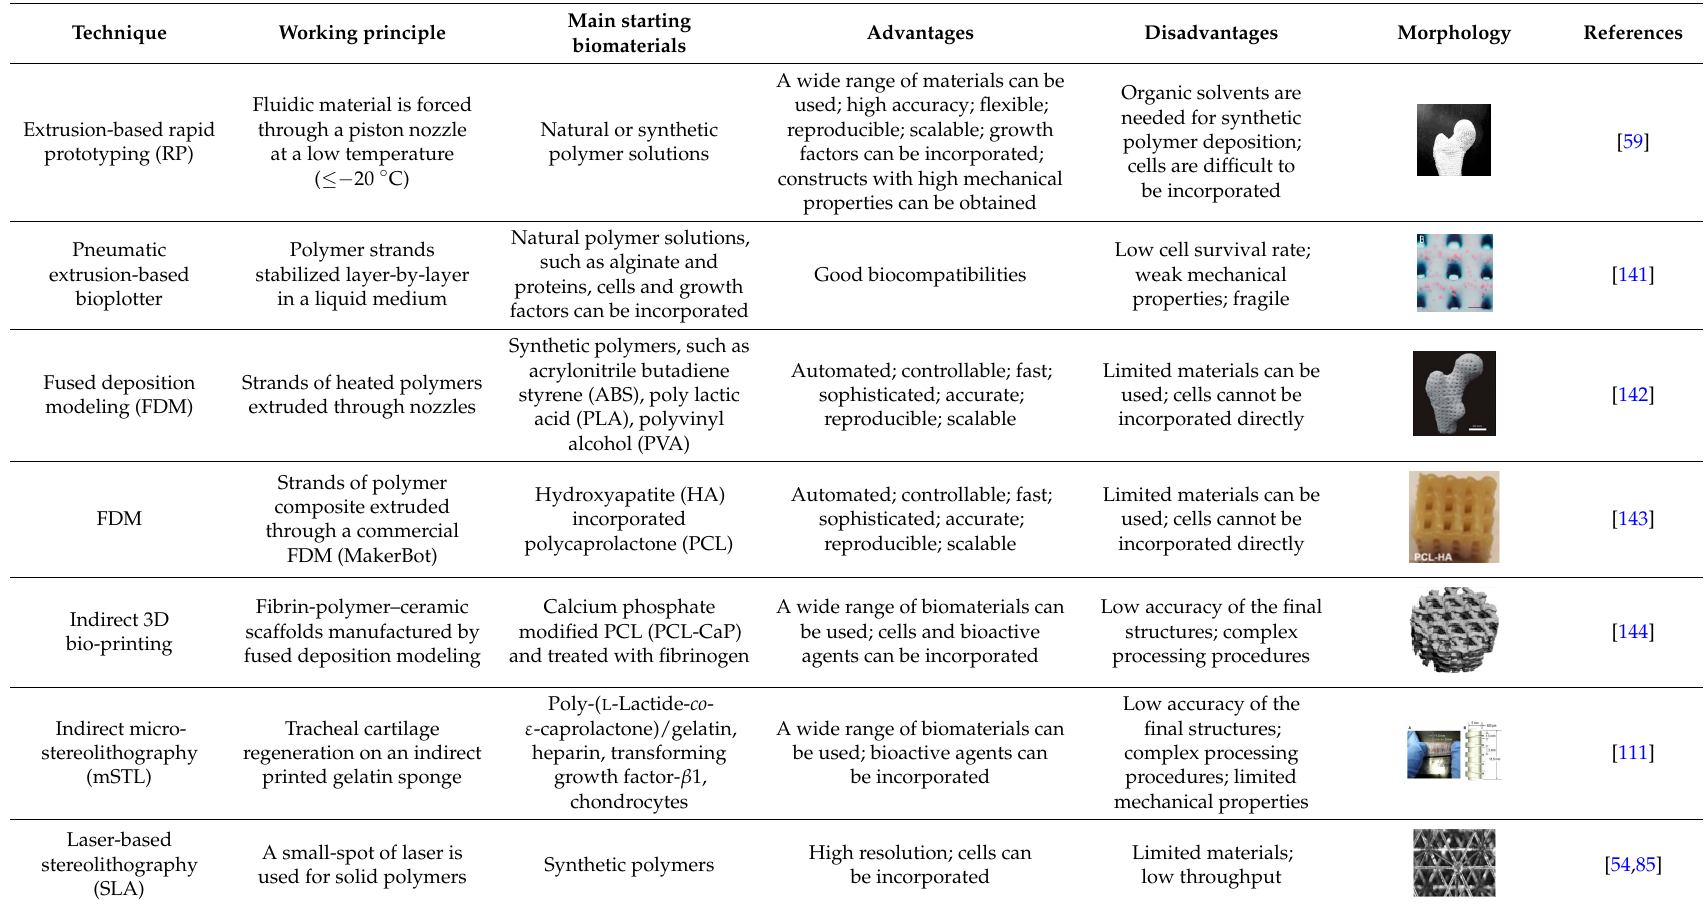
Table 1. Typical three-dimensional (3D) bioprinting technologies for hard tissue and organ engineering.